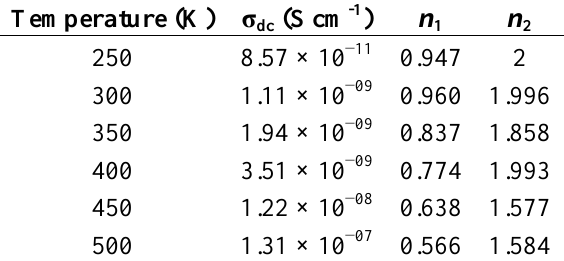
Table 1. The double power law parameters obtained by fitting the experimental data. Reprinted with permission from [15]. Copyright 2012 AIP Publishing LLC.